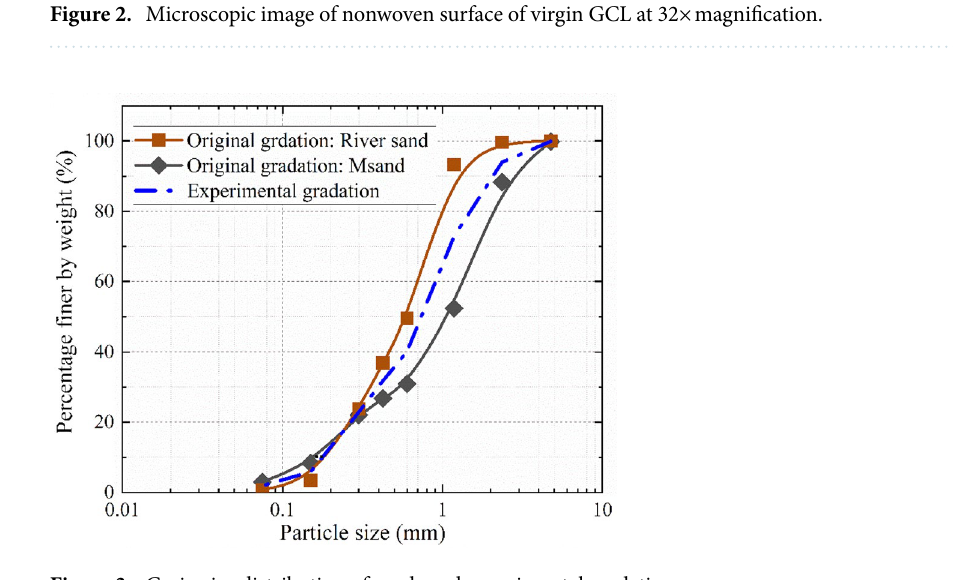
Figure 3. Grain size distribution of sands and experimental